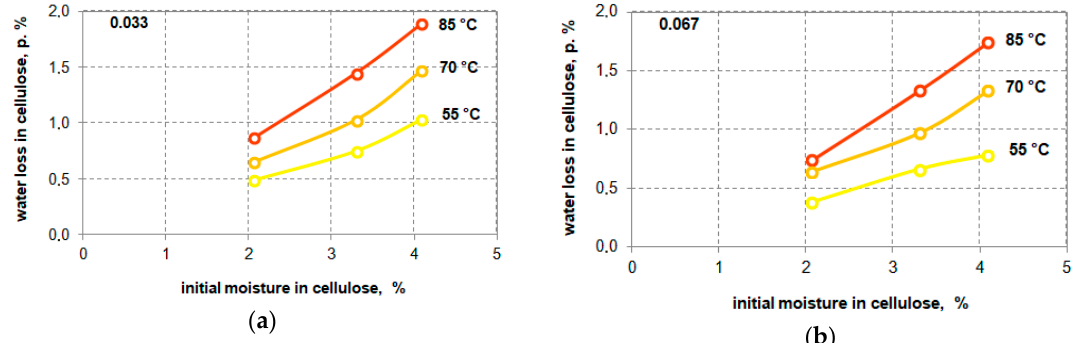
Figure 6. Water loss in samples depending on the initial moisture content of the cellulose at different temperatures; sample thickness 3 mm; initial moisture of the ester 70 ppm; total drying time 168 h—with the three times introduction of the ester; mass ratio of cellulose to ester of 0.033 ( a ) and 0.067 ( b ).